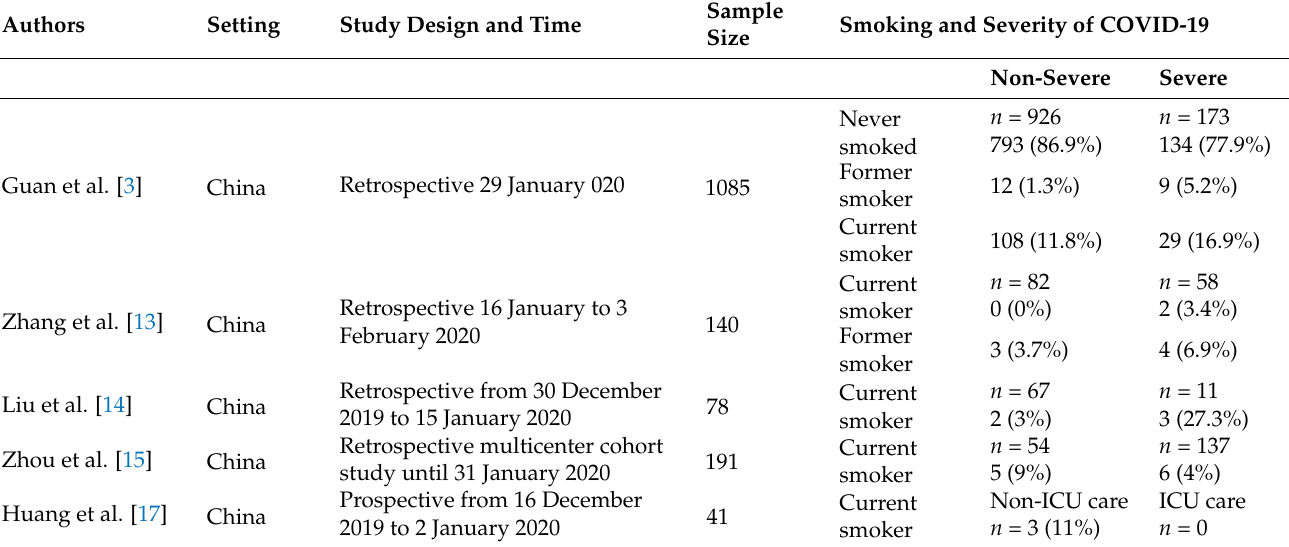
Table 1. Association of smoking with negative progression and adverse outcomes of